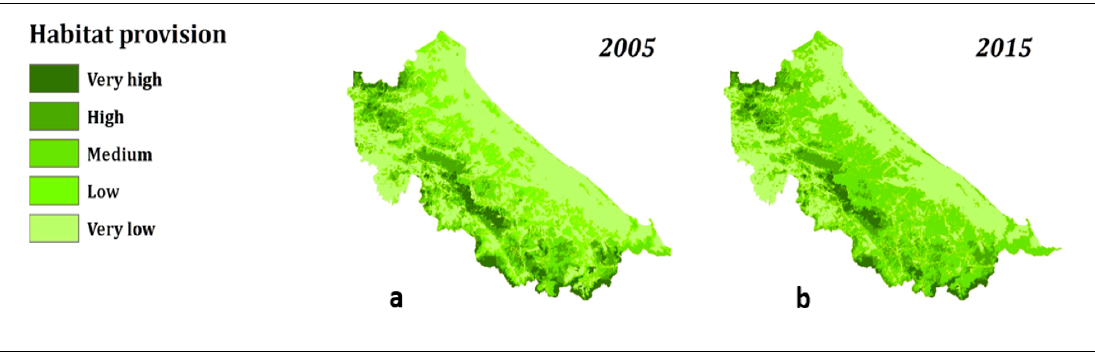
Figure 7. Distribution of habitat provision across the study area. ( a ) Habitat provision in 2005; ( b ) habitat provision in 2015. Area with dark green colors shows the area with high habitat provision; light green indicates the area with a medium capacity of habitat provision and yellowish-green shows the area has inadequate habitat provision.